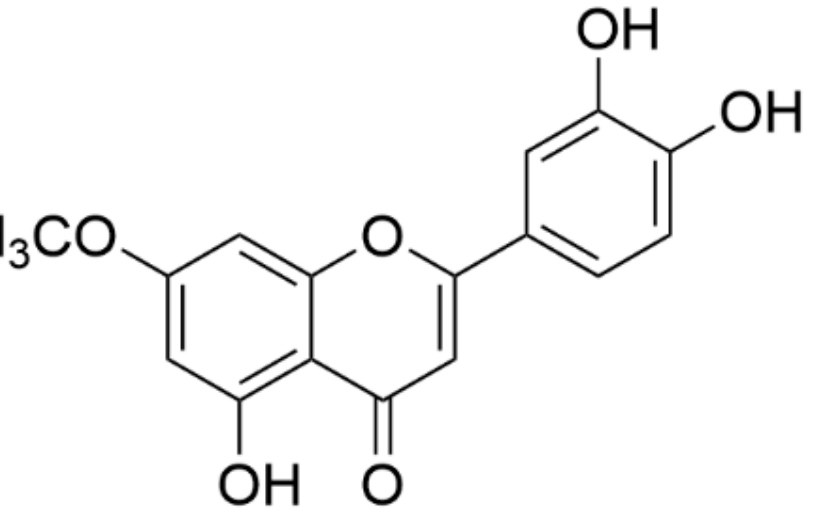
Figure 1. Chemical structure of 7- O -methylluteolin.